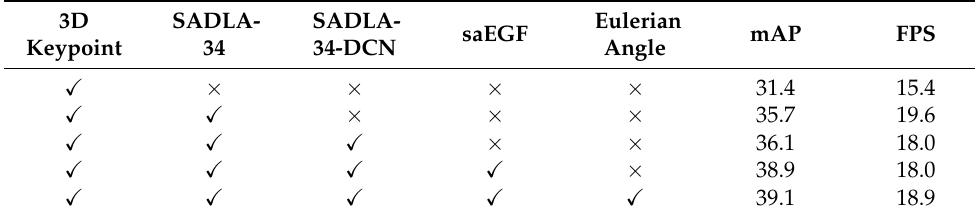
the effect of the five proposed strategies at the detection accuracy and efficiency